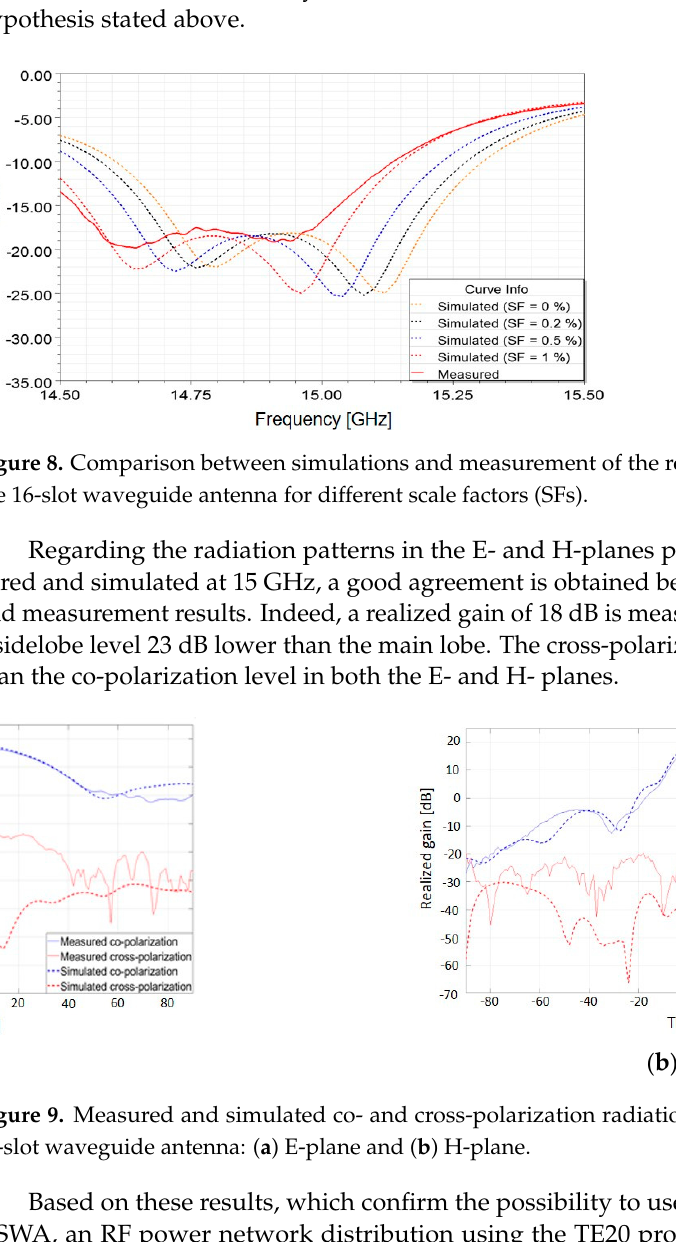
Figure 7. Simulated gain pattern at 14.89 and 15 GHz of the 16-slot waveguide antenna: ( a ) E-plane and ( b ) H-plane.